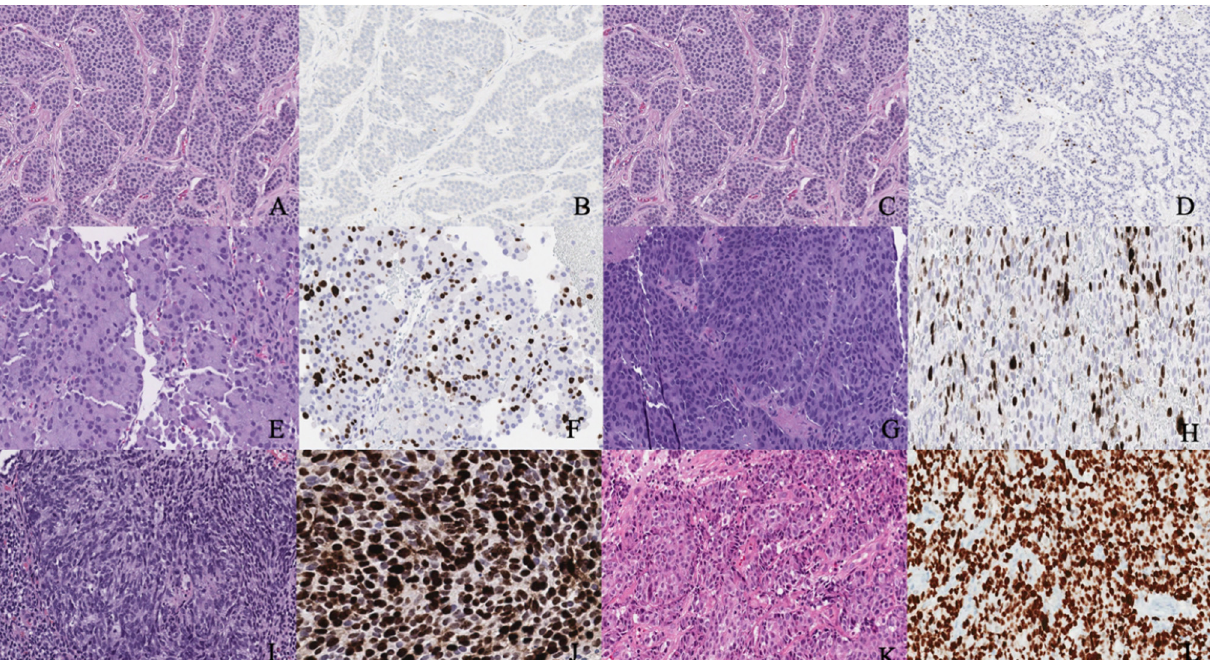
Figure 1. Categories and progress overview of neuroendocrine tumor biomarkers.